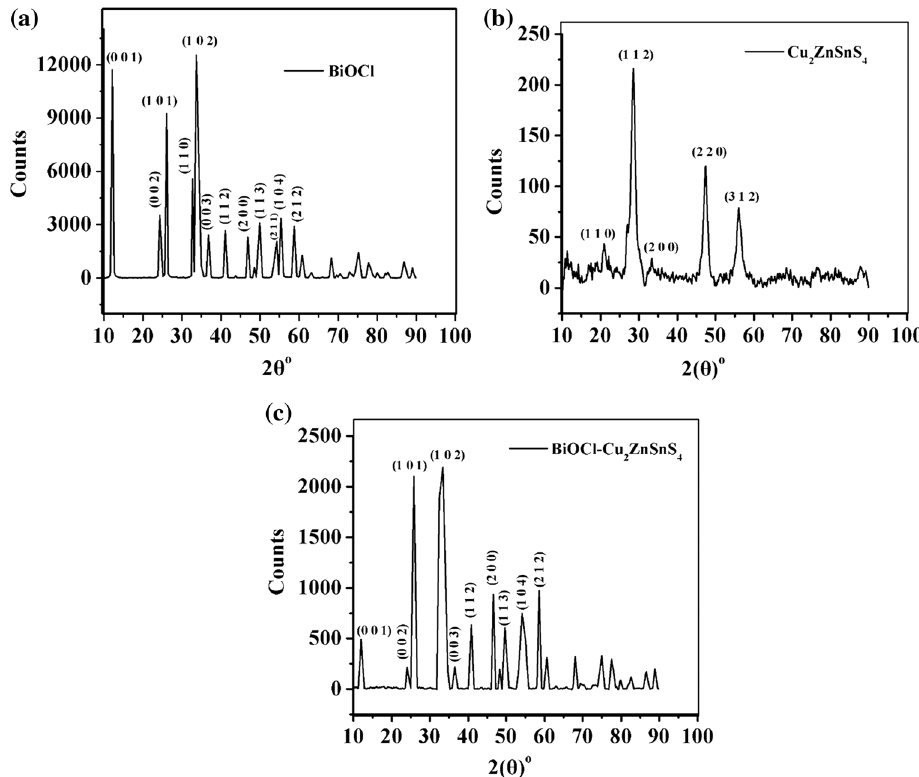
Fig. 1 XRD pattern of a Cu 2 ZnSnS 4 QDs, b BiOCl and c BiOCl–Cu 2 ZnSnS 4